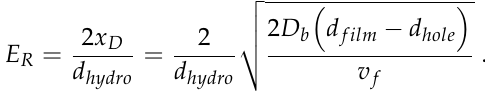
Table 2. Conditions for the calculation of physical parameters in the theoretical analysis. Characteristic parameters for physical parameters